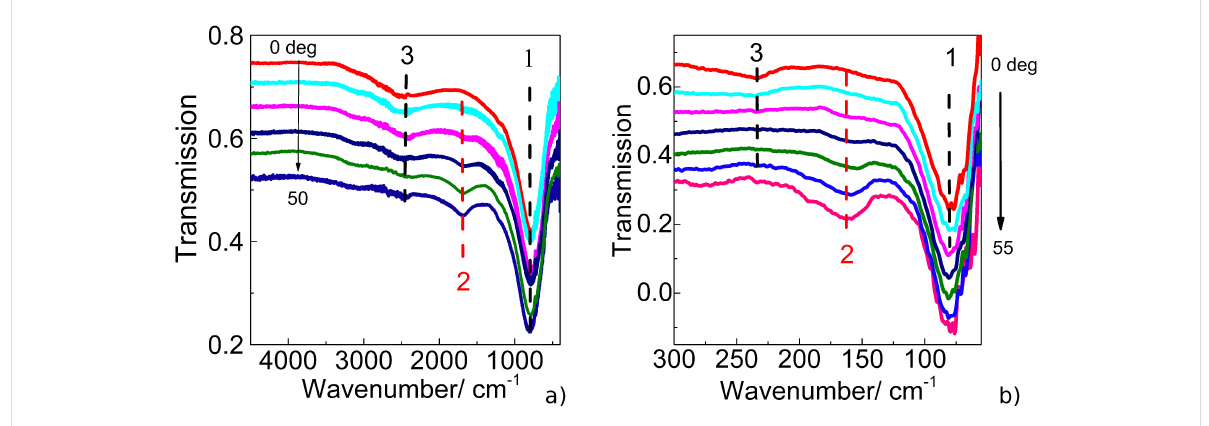
Figure 5: IR transmission spectra of the array of a) nanoantennas and b) microantennas measured at different angles of incidence, TM polarization. The vertical dashed lines with numbers indicate the positions of the LSPR modes of the corresponding order.